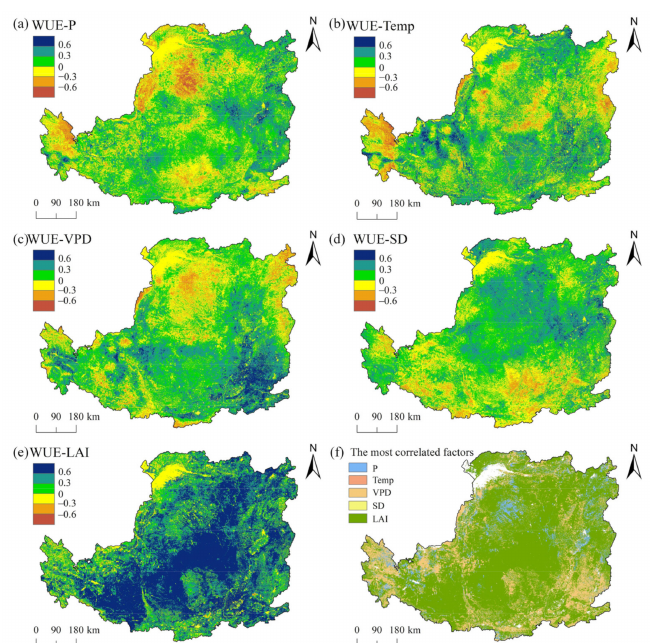
Figure 6. Spatial distributions of the partial correlations between WUE and ( a ) P, ( b ) Temp, ( c ) VPD,